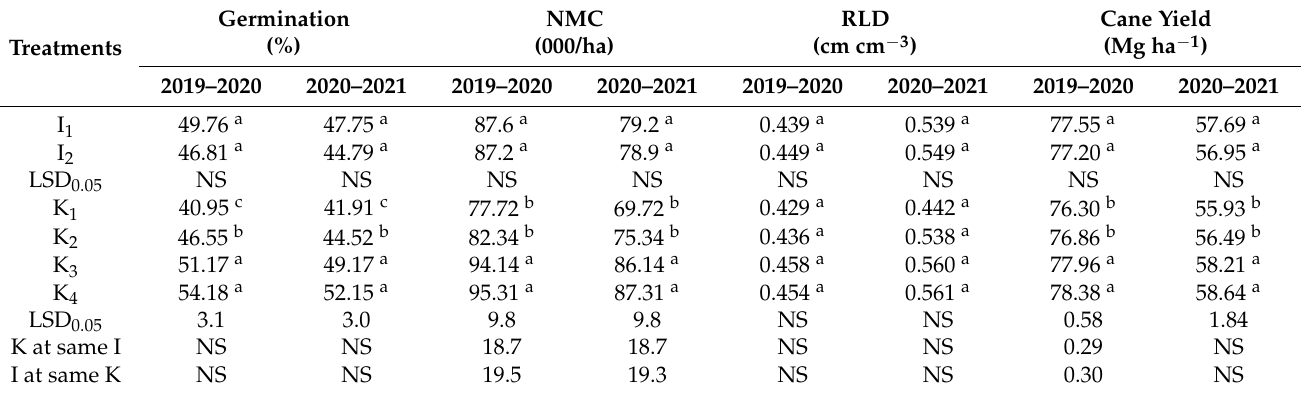
Table 3. Germination, NMCs, RLDs, and yields of sugarcane as a function of irrigation and potash levels.